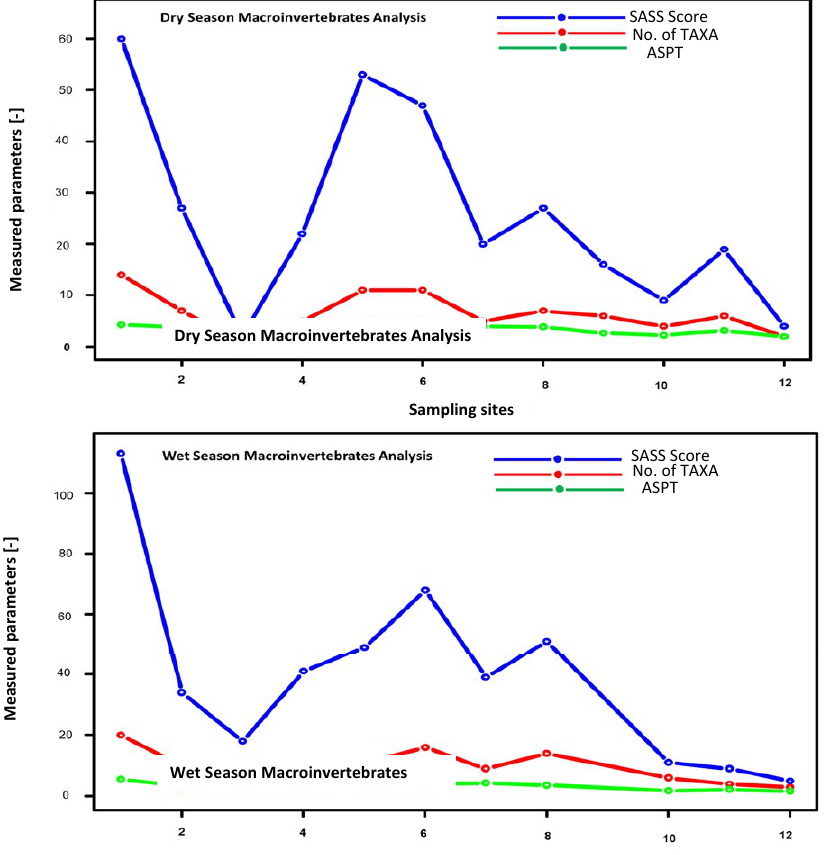
Fig 5: Results of macroinvertebrate scores, number of Taxa, and the average score per taxon (ASPT) in dry and wet seasons on the Mukuvisi River based on SASS 5.